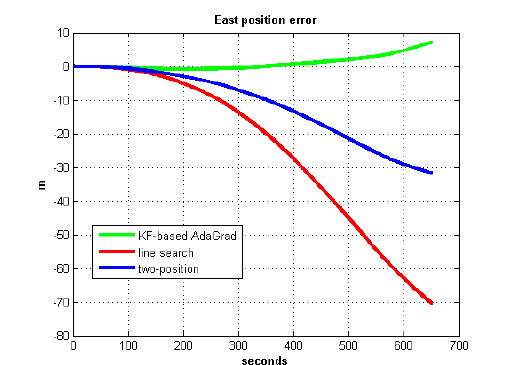
Figure 18. North velocity error in test 1.